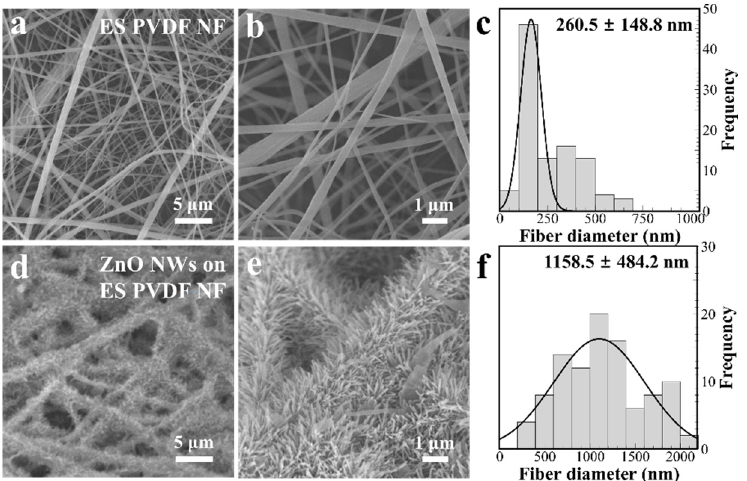
Figure 2. Scanning electron microscope (SEM) images showing surface morphology analysis of ( a , b ) PVDF NF layer and ( d , e ) ZnO NW on the PVDF NF layer. ( c , f ) Average diameter and distribution analysis of the NFs.